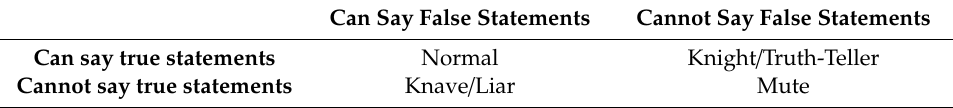
Table 1. Type of people and their possible statements by their truth value in the